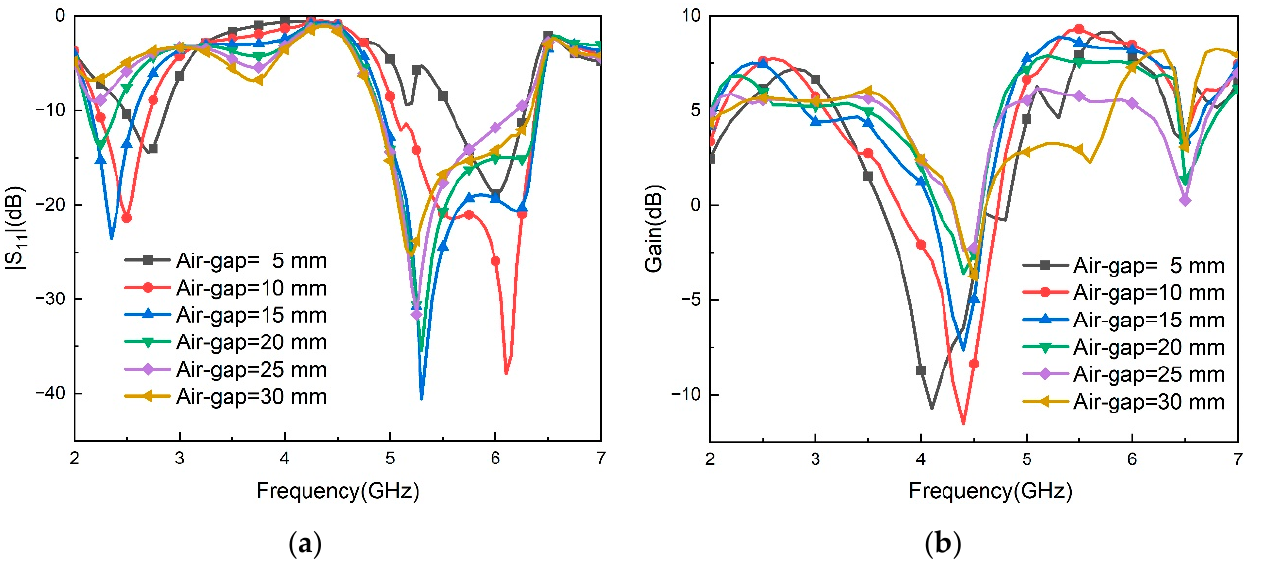
Figure 8. The antenna performance of various values of “air ‐ gap” parameter ( a ) |S 11 | and ( b ) gain. The antenna and the FSS are simulated and optimized. After combining the two substrates, the input impedance would be influenced especially at 2.45 GHz. In order to realize the impedance matching again, many parameters of the antenna are analyzed. The antenna impedance is sensitive to a key parameter Botm_L 1 , which is shown in Figure 9. In Figure 9, impedance curve fluctuation is relatively large in the low operating bands, but it stays relatively flat when the resistance is about 50 Ohm and the reactance is 0 Ohm in